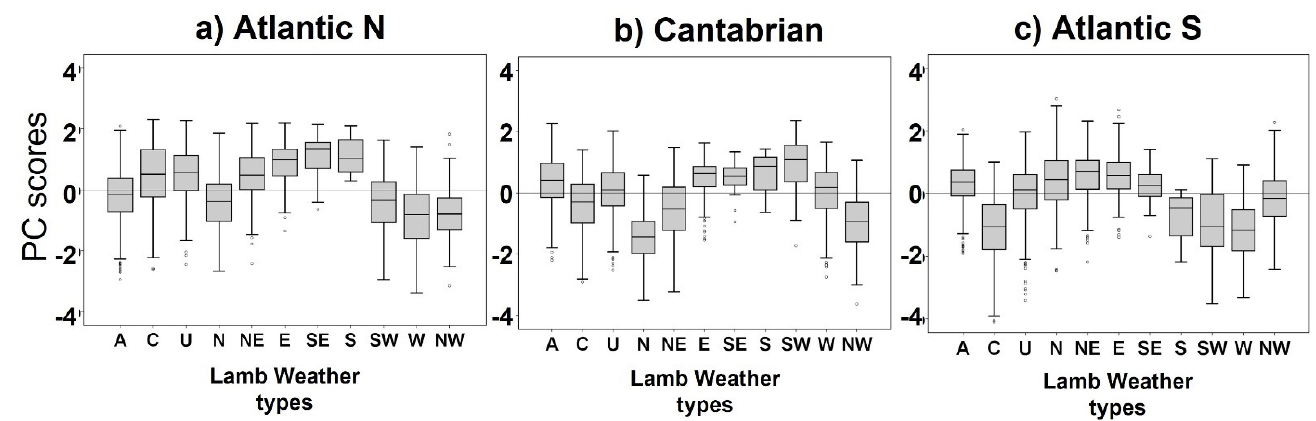
Figure 4. Box plot showing the within-group variance of daily PC scores according to each LWT for the ( a ) Atlantic N region ( b ) Cantabrian region and ( c ) Atlantic S region. The boxplot presents the median, maximum, minimum, lower, and upper quartile of daily values. Outliers, represented as dots, are also indicated as any point falling below QL—1.5 × inter quartile range (IQR) or above QU—1.5 × IQR, where IQR is the difference between the two quartiles. X axis labels correspond to each LWT (see Appendix C). Table 3. F -values and significance from an ANOVA procedure to determine whether the mean values of the Principal Component scores within the synoptic categories were significantly differ- ent, and selected circulation pattern on each region.